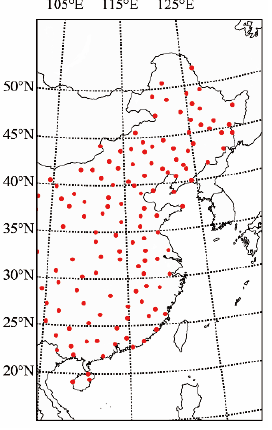
Figure 1. Locations of observation stations in the study.